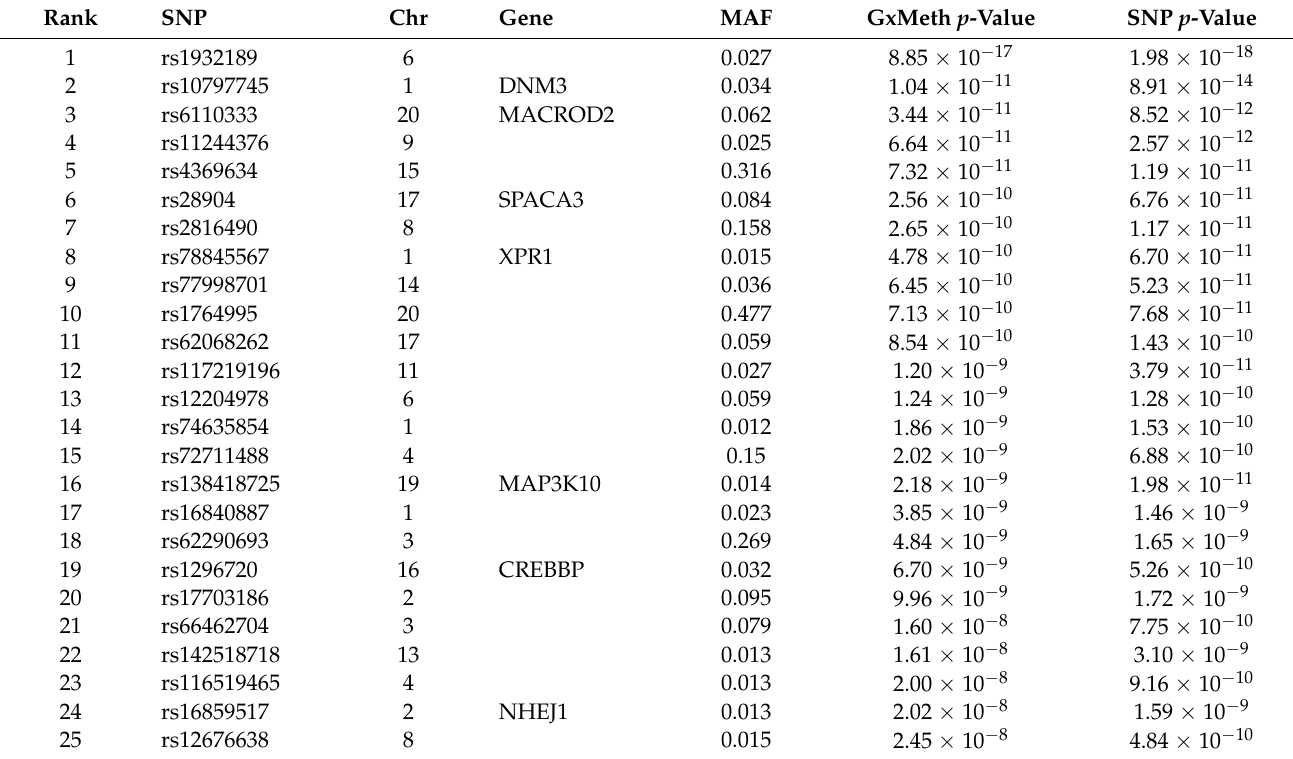
Table 11. Top 25 ranked SNPs with GxMeth effects after Bonferroni